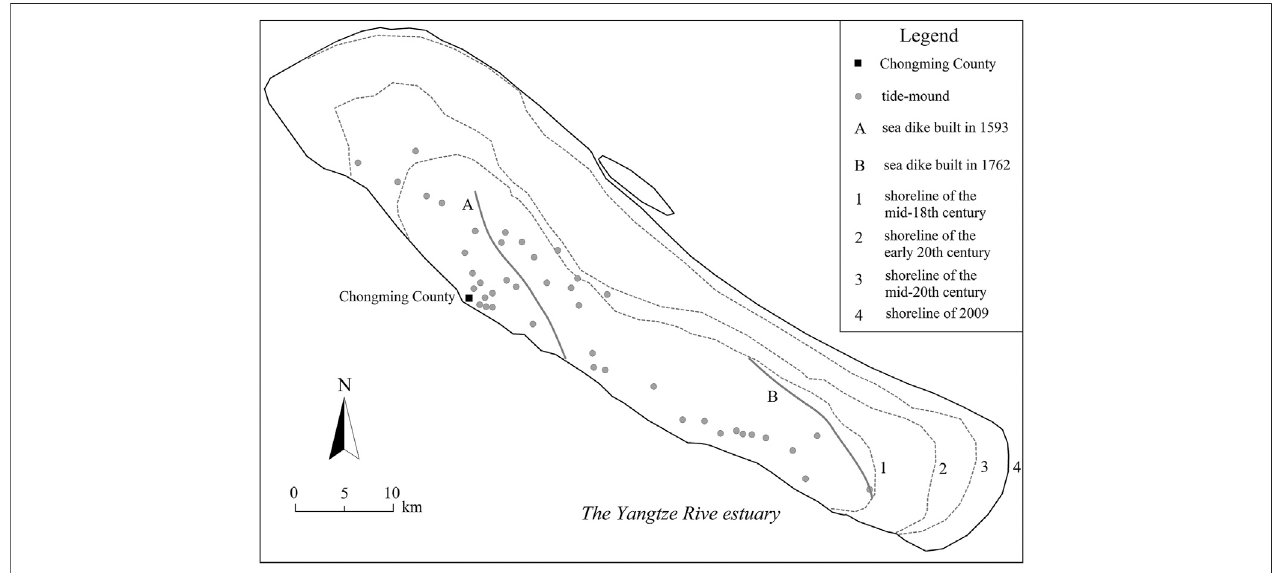
FIGURE 4 | Historical shoreline, sea dike and tide-mound changes of Chongming Island. The distribution changes of tide-mounds and sea dikes were from the ChroniclesofChongmingCounty(Zhuetal.,1688;Zhangetal.,1727;Zhaoetal.,1760;Linetal.,1881;Cao1930,seeAppendix).Dataonshorelinechangeswerefrom the Chronicles of Chongming County (Cao 1930; Yun,